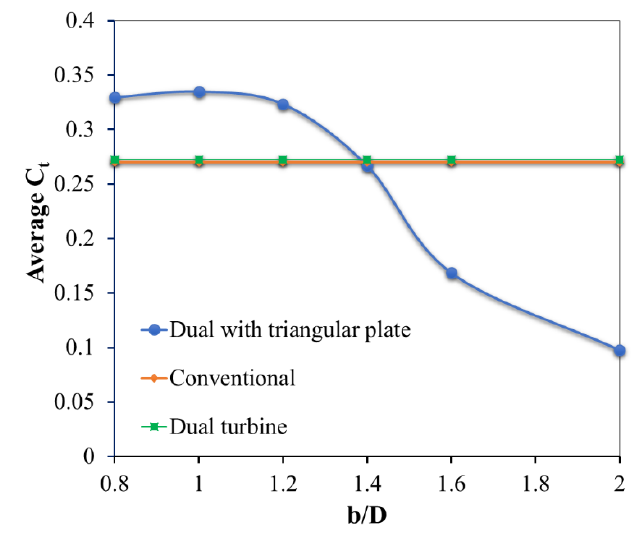
Figure 12. Comparison of torque coefficients.